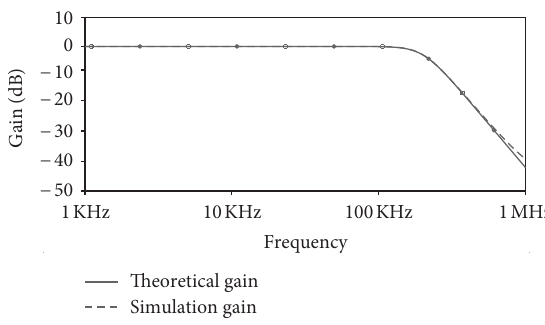
F 5: Frequency response of third order lowpass �lter.